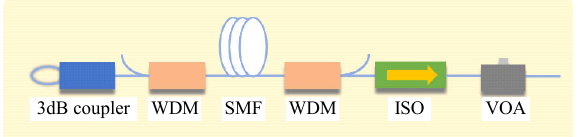
Fig. 1 Experimental setup. MMF: multimode fiber; USAF: US Air Force resolution chart; CCD: charge-coupled device camera.